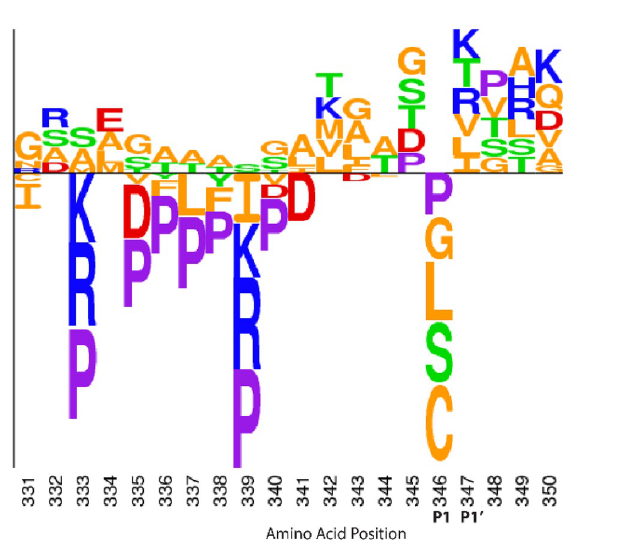
Figure 6. Deep mutational scanning of PAI-1 provides insight into the mutational landscape of PAI-1’s RCL. Relative log 2 -fold change scores of missense mutations in PAI-1’s RCL (amino acids 331–350) following selection by ability to inhibit uPA 39 . Amino acids below the x-axis indicate depletion (log 2 -fold change < 0), while those above the x-axis indicate enrichment (log 2 -fold change > 0). Letter height corresponds to the relative log 2 -fold change. Residues are color coded by properties: acidic residues in red, basic residues in blue, polar amino acids in green, non-polar amino acids in orange, and Pro in purple 39 . The P1 and P1 ′ positions (Met 346 and Arg 347 in WT) are also indicated. This figure was generated using Adobe Illustrator 2021 version 25.2.3 and Seq2Logo 2.0 (http:// www. cbs. dtu. dk/ bioto ols/ Seq2L